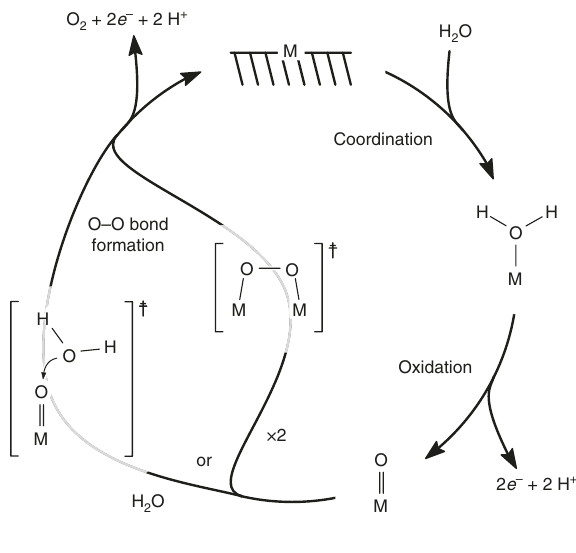
Fig. 1 Minimal mechanism of the OER at a solid metal oxide